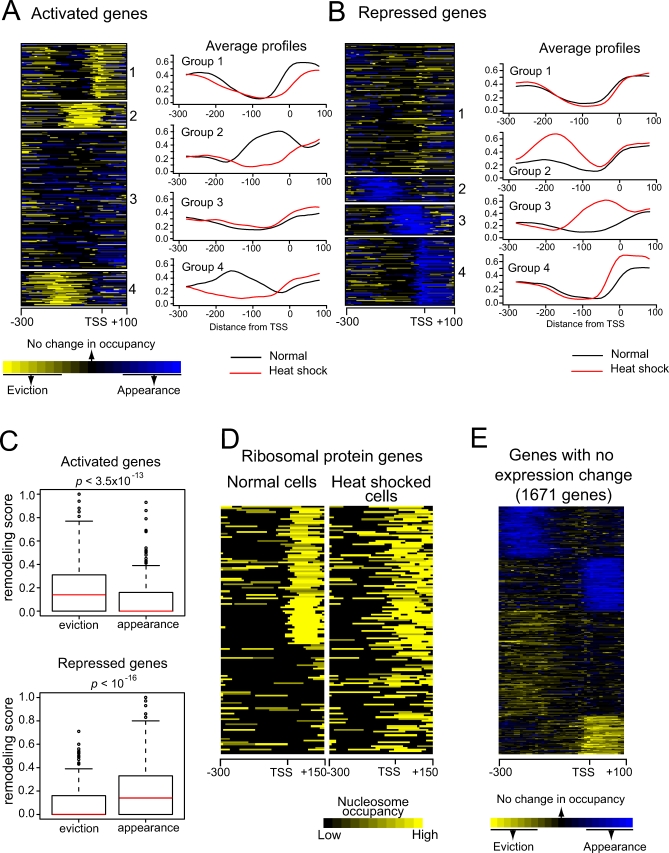
Classification of Promoter Nucleosome Remodeling ProfilesAll profiles are aligned with respect to the TSS.(A) Remodeling profiles of genes activated greater than 2-fold after heat shock and (B), genes repressed greater than 2-fold by heat shock. Nucleosomes present during normal growth but evicted by heat shock are indicated in yellow, and nucleosomes that appeared after heat shock are shown in blue. The average profiles of nucleosomes in each group before and after heat shock are shown on the right. The k-means clustering for (A) and (B) was done based on data from −200 to TSS, but data are shown for −300 to +100.(C) A remodeling score for eviction and for appearance was separately calculated for activated genes and repressed genes (Materials and Methods), and the data were plotted using box plots similar to Figure 3B. Activated genes showed significantly higher eviction scores than appearance scores, whereas repressed genes showed significantly higher appearance scores than eviction scores.(D) Nucleosome positions at the promoters of ribosomal protein genes during normal growth and after heat shock, clustered on data from −200 to +100 bp.(E) Remodeling profiles of genes whose expression changed by less than 1.2-fold after heat shock, clustered based on data from −300 to +100 bp.